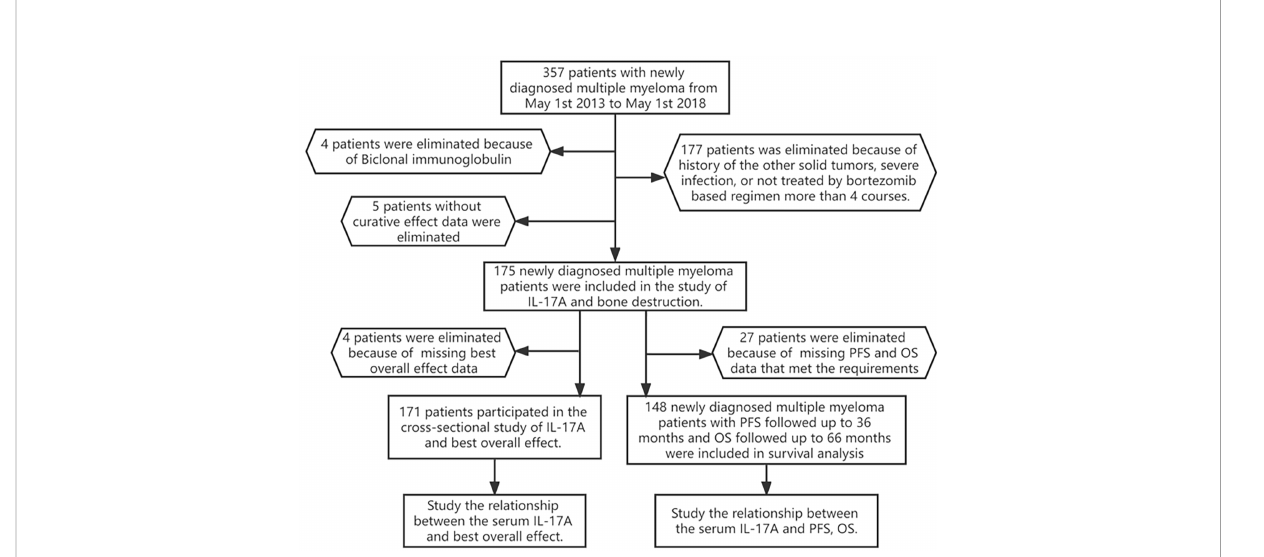
FIGURE 1 Flowchart of participants. A total of 175 patients participated in the cross-sectional study of IL-17A and bone destruction; 171 patients participated in the study of IL-17A and the best overall effect; 148 newly diagnosed multiple myeloma patients with PFS/OS were followed up for 30 months. PFS, progression-free survival; OS, overall